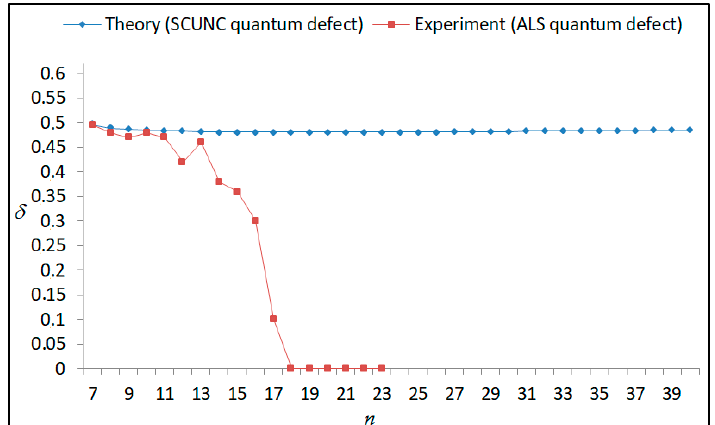
Figure 21. Variations of the quantum defect ( δ ) with the principal quantum number n for the 4 s 2 4 p 2 ( 1 D 2 ) ns ( 2 D ) Rydberg series originating from the 2 D ° 3/2 metastable state of Se + converging to the 1 D 2 series limits in Se 2+ .